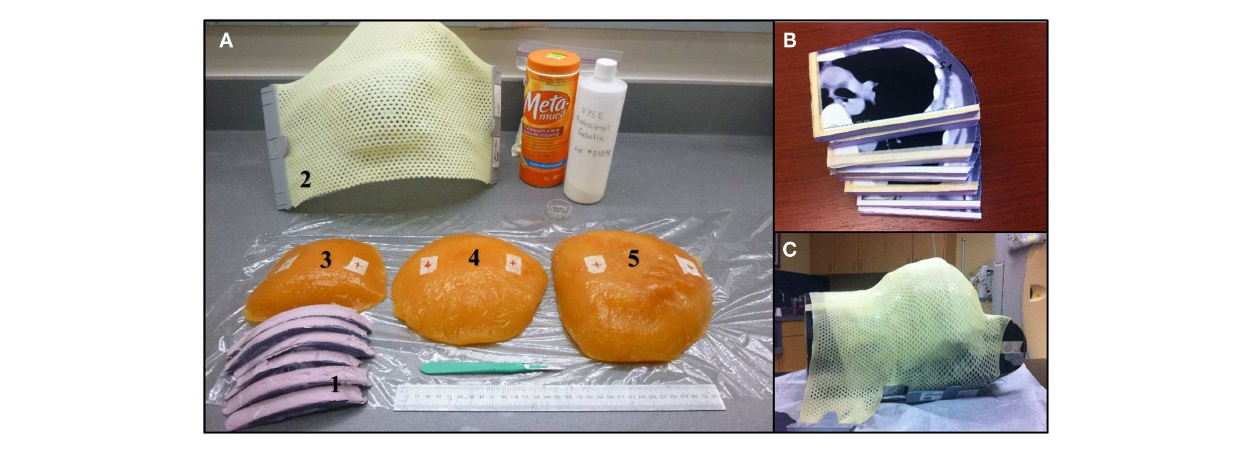
gelatin-based breast phantoms. (B) Styrofoam slices cut to the patient profile using CT images. (C) Thermoplastic mold over the Rando phantom modified with the large breast to ensure good